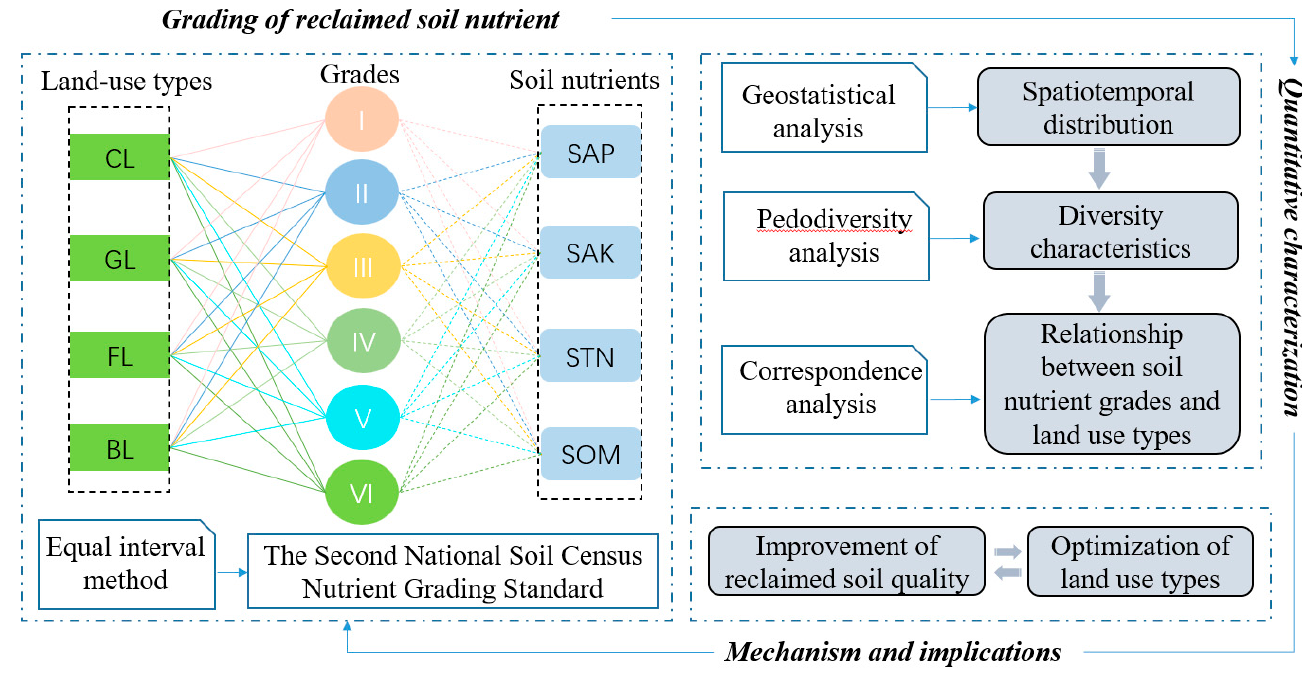
Figure 2. Methodological framework (CL. Cultivated land; GL. Grassland; FL. Forestland; BL. Barren land).